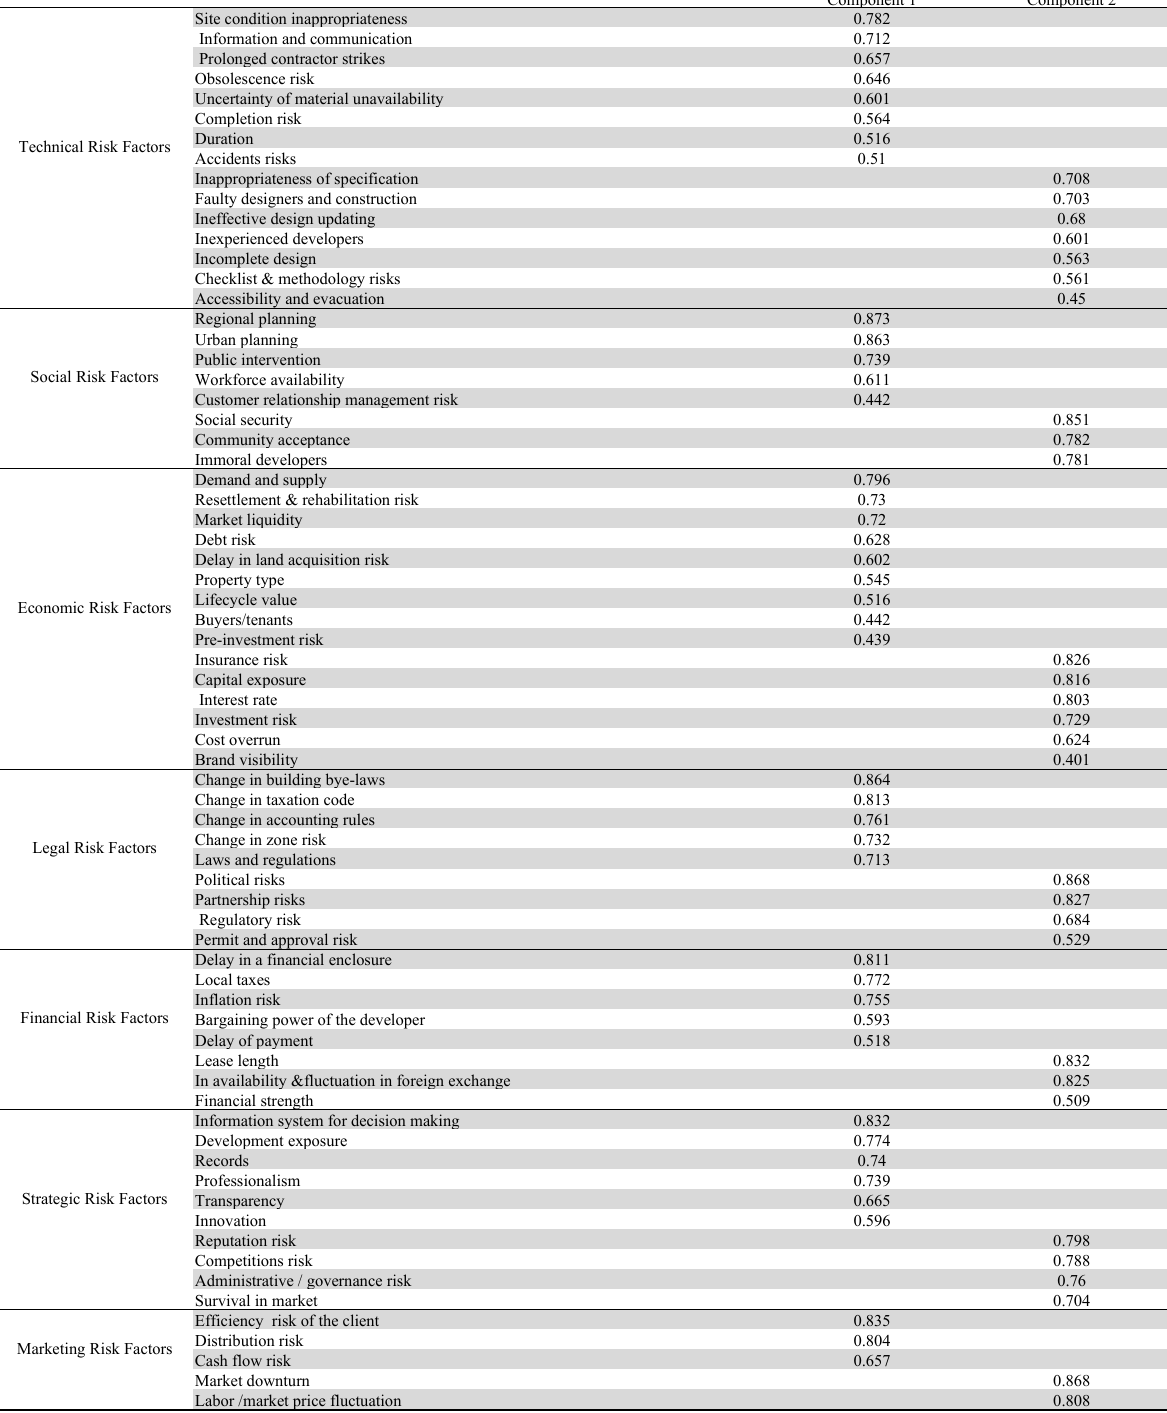
Varimax Rotated Factor Loadings with Rotated Component